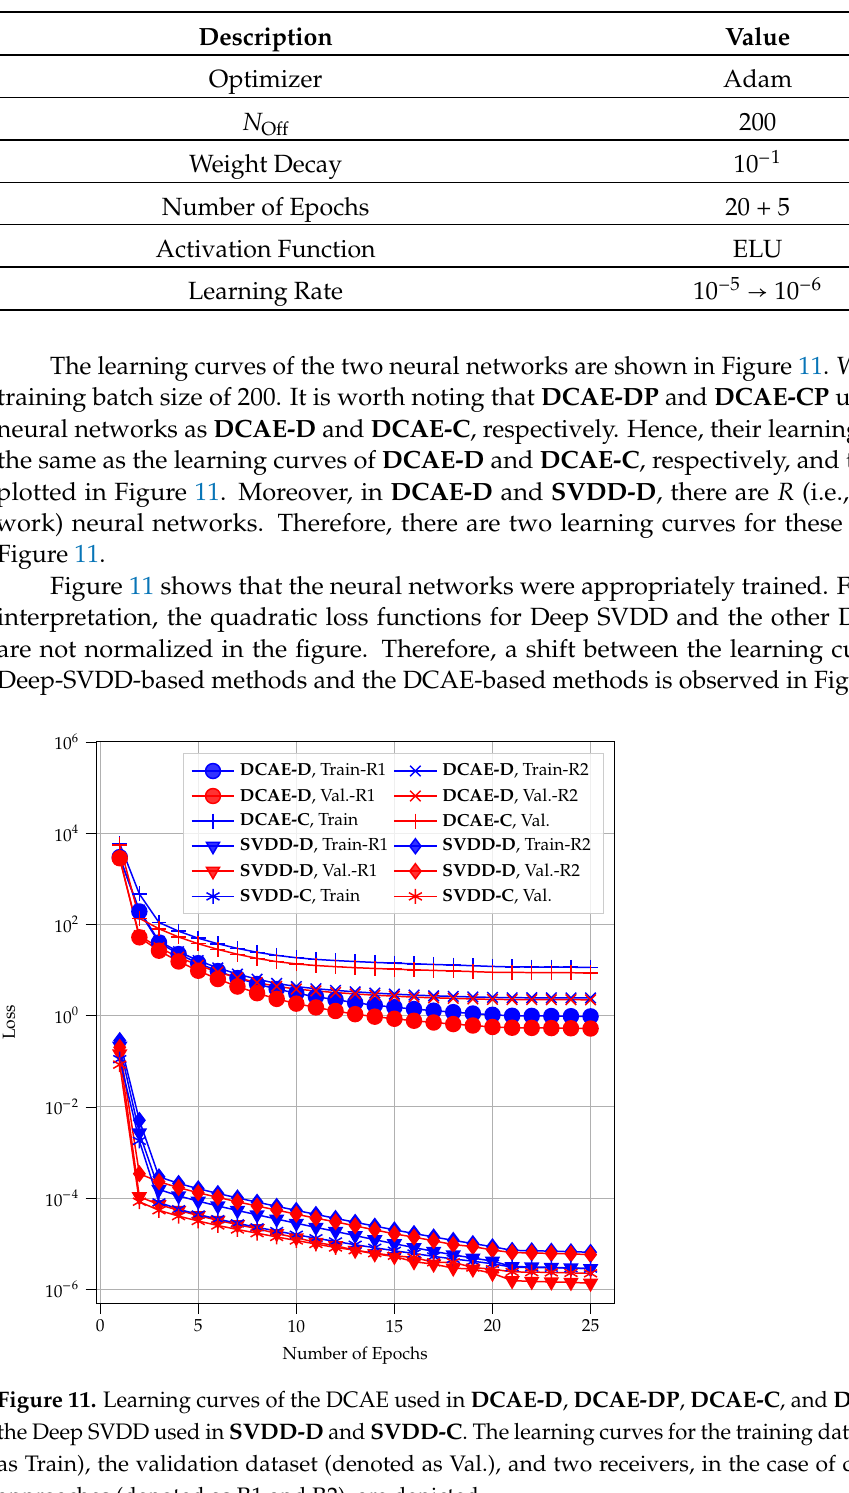
GPU. Table 4 summarizes the parameters used to train the neural networks. Table 4. Neuralnetwork parameters.